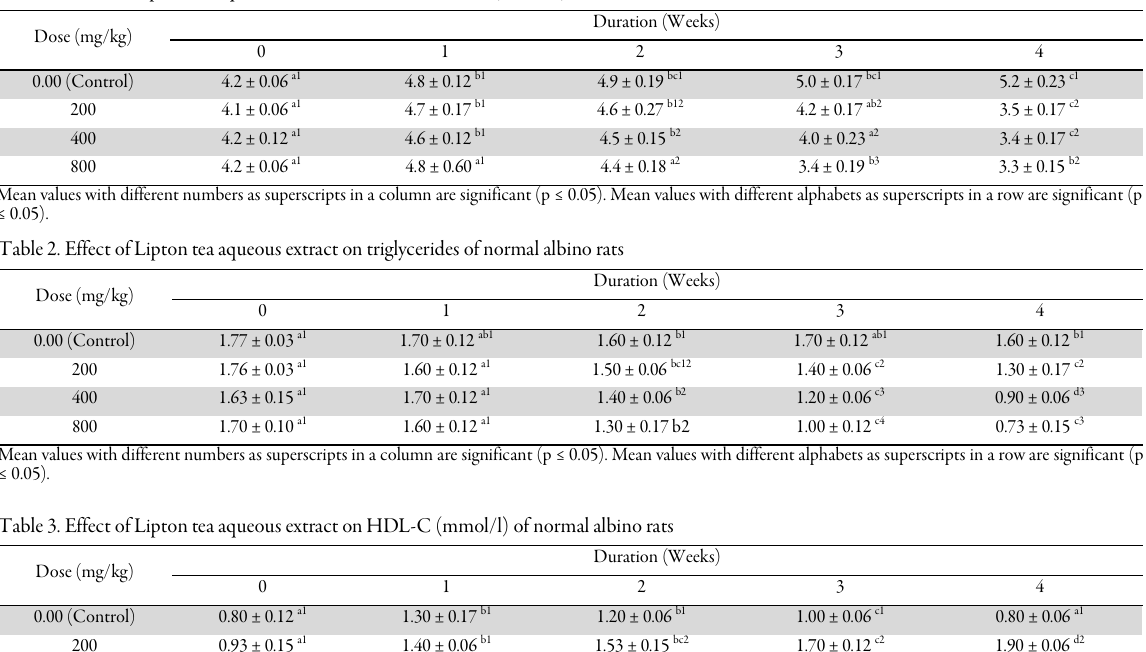
Table 1. Effect of Lipton tea aqueous extract on total cholesterol (mmol/l) of normal albino rats Dose (mg/kg)